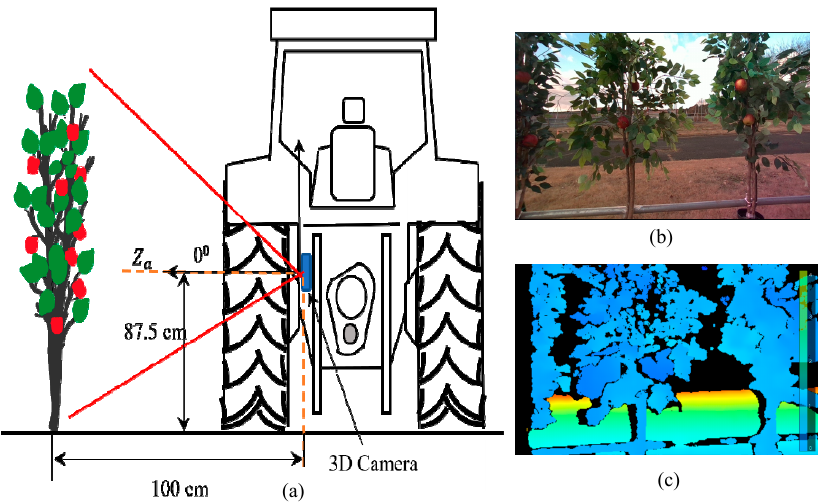
Figure 9. ( a ) A 3D camera at 90° orientation, ( b ) RGB stream corresponding to the 90° orientation, and ( c ) a depth map.